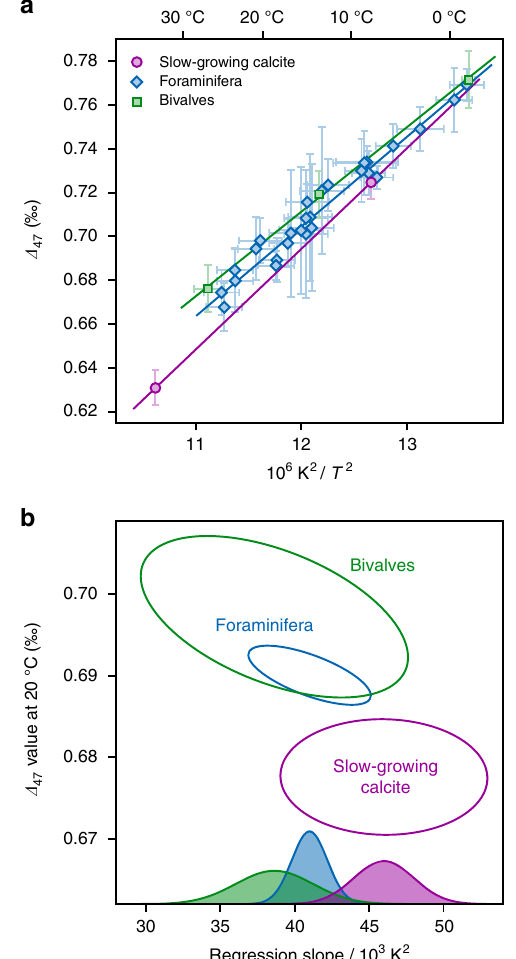
Fig. 2 Three calibrations of clumped isotopes in carbonates ( Δ 47 ) as a function of crystallization temperature T . a Observed relations between Δ 47 and T in slow-growing calcite from Devils Hole and Laghetto Basso, in modern calcitic bivalves (Supplementary Table 2), and in foraminifera from sedimentary core-tops (data from Peral et al. 45 ), all of which were analyzed in the same laboratory over a short period of time. Error bars represent 95% con fi dence intervals. Solid regression lines take into account analytical errors in Δ 47 as well as uncertainties on crystallization temperature. b Comparison of the 95% con fi dence regions of regression slopes and 20 °C intercept values for slow-growing and biogenic calcite. Both of the biogenic regression lines differ signi fi cantly ( p ≤ 10 − 3 ) from the equilibrium baseline de fi ned by slow-growing calcites. Colored bell-shaped curves represent the